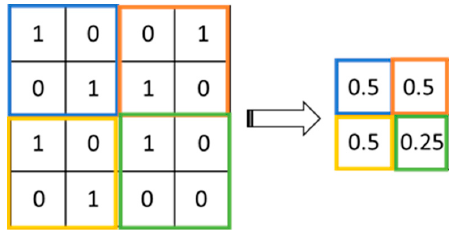
Figure 4. Schematic diagram of average pooling.